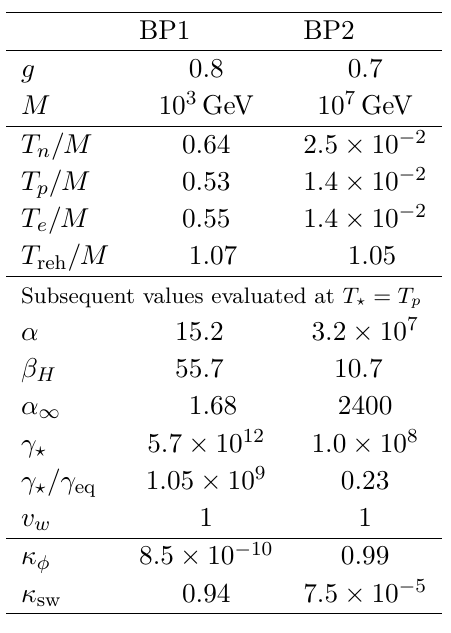
Table 1 . Two benchmark points to illustrate bubble wall behavior. BP1 exhibits a small amount of supercooling with a large gauge coupling, hence sound-waves dominate the GW signal, while BP2 is in the opposite regime with an extreme amount of supercooling and small gauge coupling. Hence the GW signal is dominated by collisions of the bubble walls